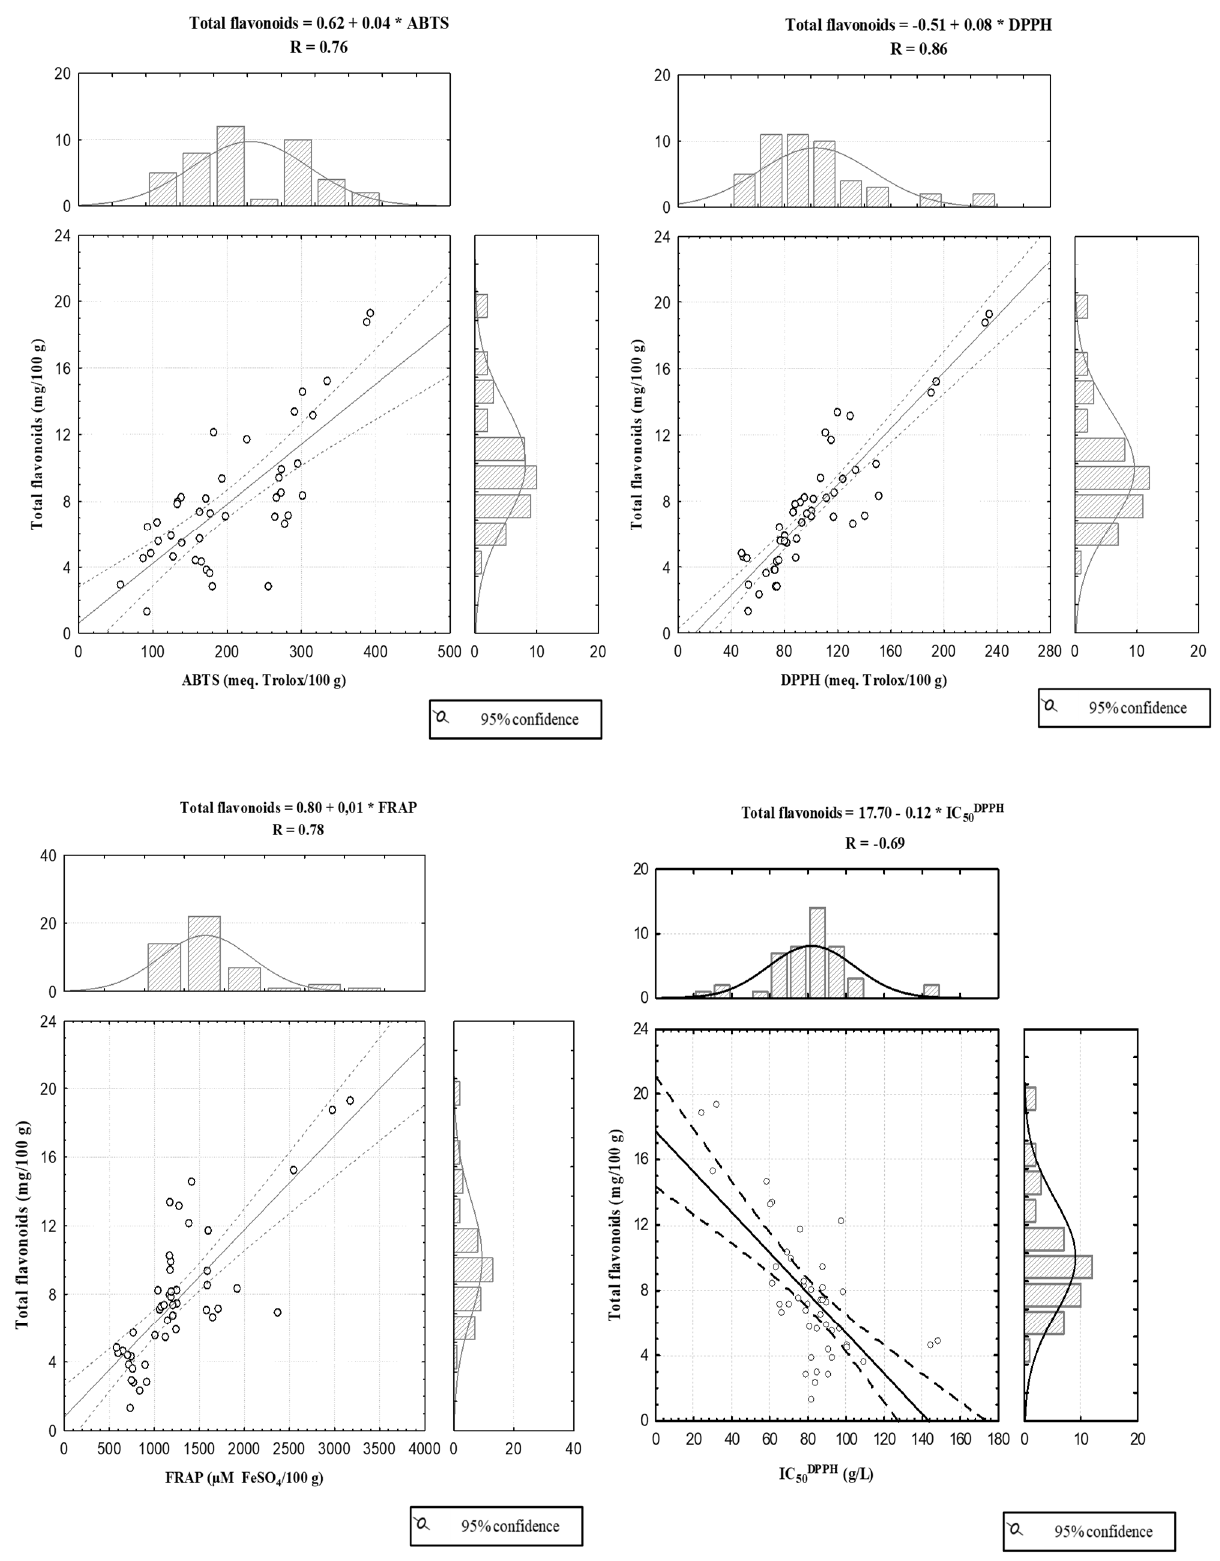
Figure 3. Correlations established between total flavonoid content, results of the antioxidant assays and IC 50 DPPH values.